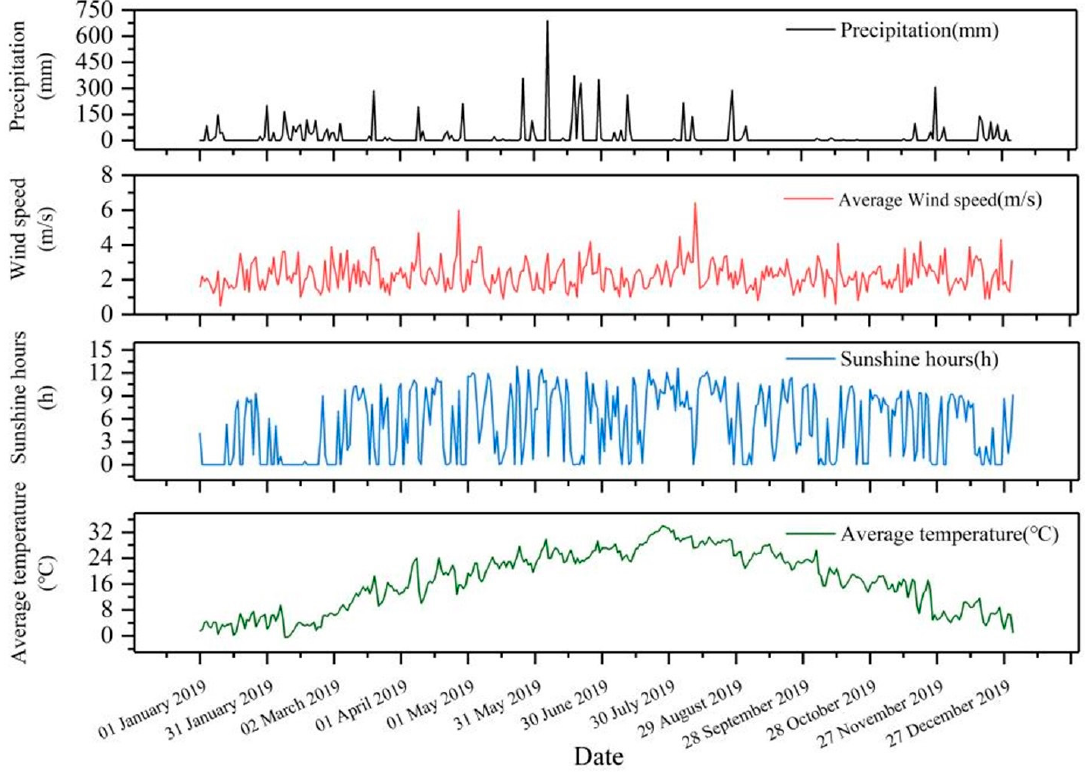
Figure 3. The variation diagram of rainfall, sunshine hours, average temperature, and precipitation in Chaohu Station in 2019.